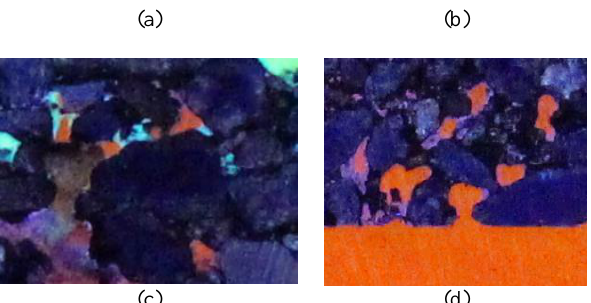
Figure 4: Examples of pores filled by resin: (a) resin on the top, which is “yellow” in surface and green in the sample. (b) isolated soiling cluster in a pore. (c) mix between the 2 resins.